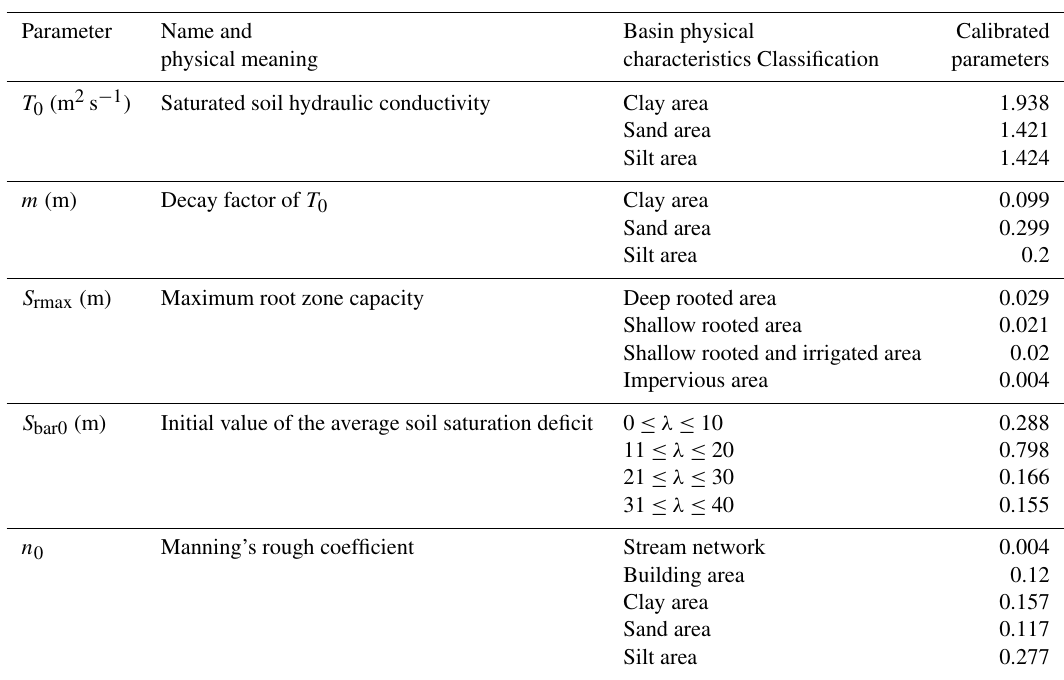
Table 4. Calibrated model parameters for BTOPMC.